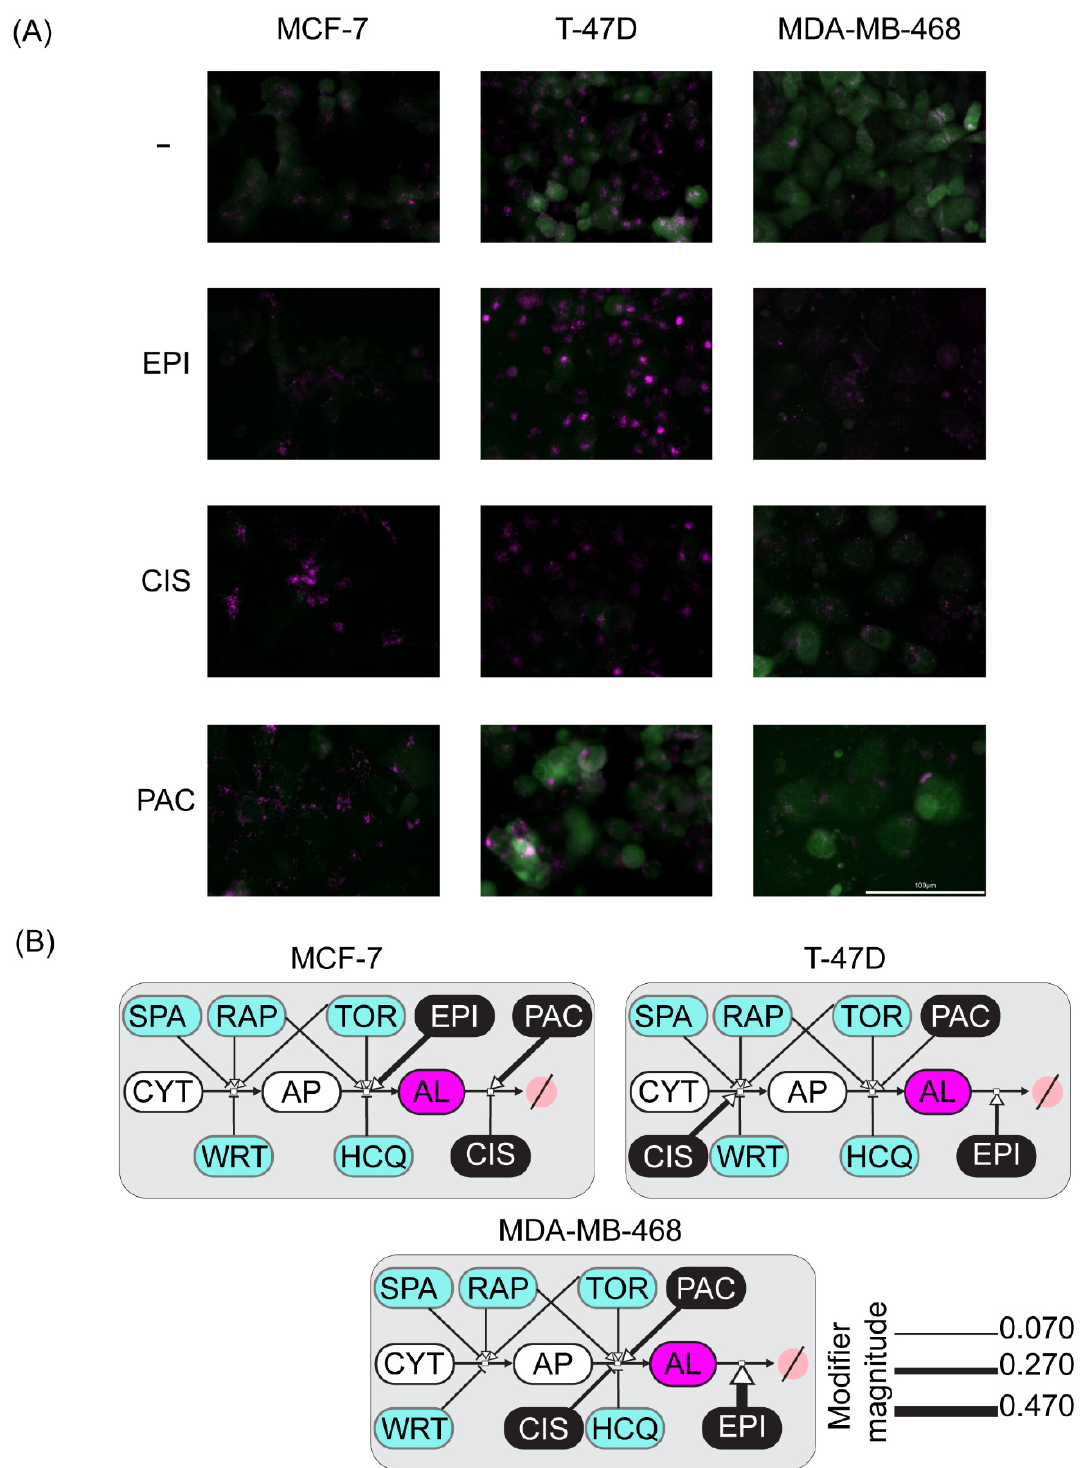
Figure 4. Perturbation-based mathematical modeling of the autophagic sensor dynamics indicates cell-line specific modes of action of chemotherapeutic agents on the autophagic flux. ( A ) Qualitative changes in the autophagy sensor induced by chemotherapeutic drugs treatment, to emphasize the differences, only the images corresponding to 48 h post-treatment are shown. ( B ) Cell-line specific modes of action of chemotherapeutic agents on the autophagic flux. A simplified topology of the autophagic flux was used. The magnitude of the modulating effect for each drug proposed activity is proportional to the line width. AL: autophagolysosomes, AP: autophagosomes, CIS: cisplatin, CYT: cytoplasm, EPI: epirubicin, HCQ: hydroxychloroquine, PAC: paclitaxel RAP: rapamycin, SPA: Spautin-1, TOR: Torin-2, WRT: wortmannin.